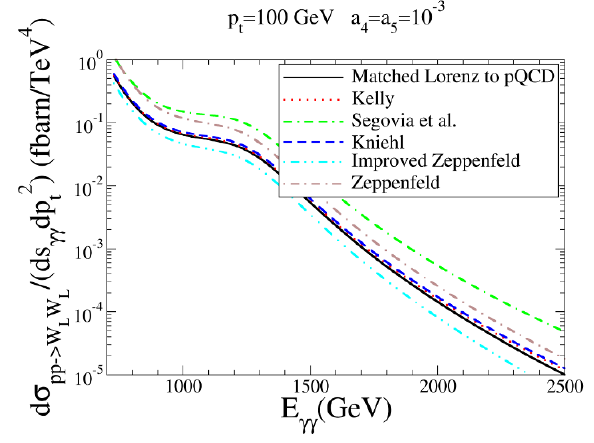
Figure 9 . Computation with the elastic photon (cid:13)ux, similar to (cid:12)gure 8, but adding the a 5 NLO parameters.